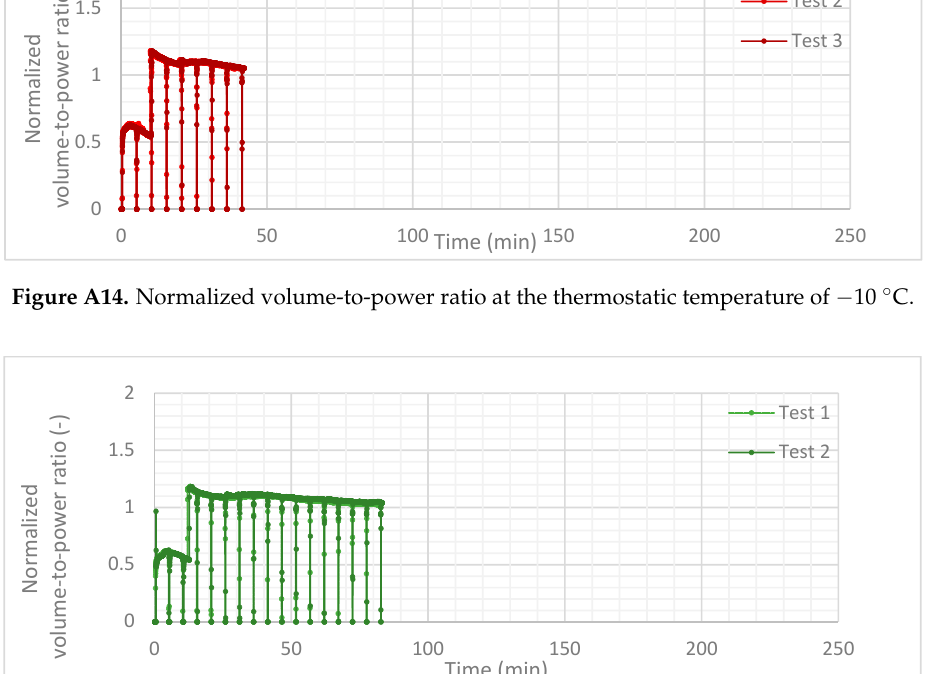
Figure A15. Normalized volume-to-power ratio at the thermostatic temperature of − 20 °C.